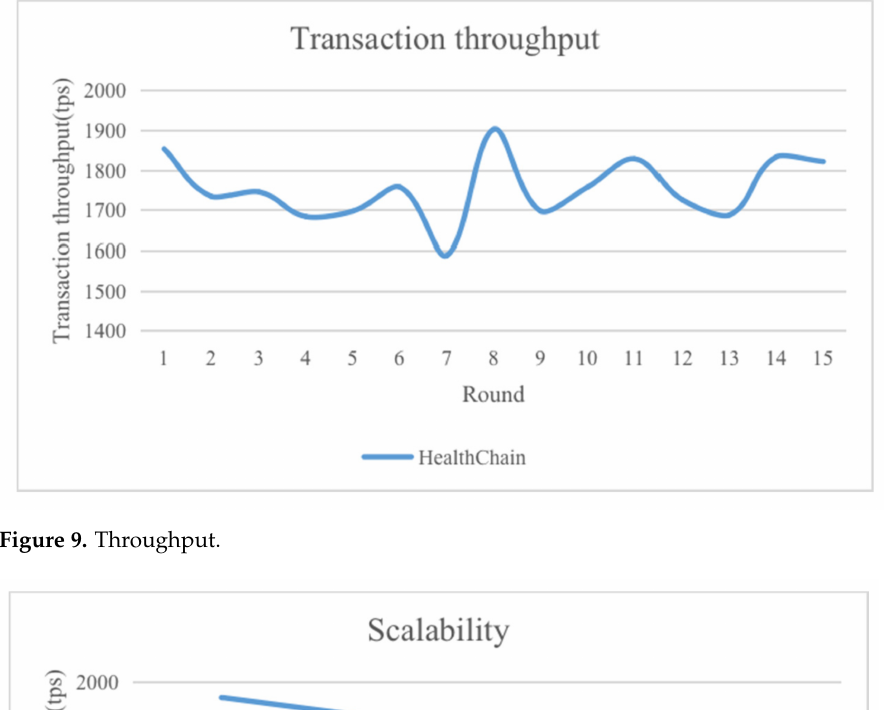
Figure 9. Throughput.